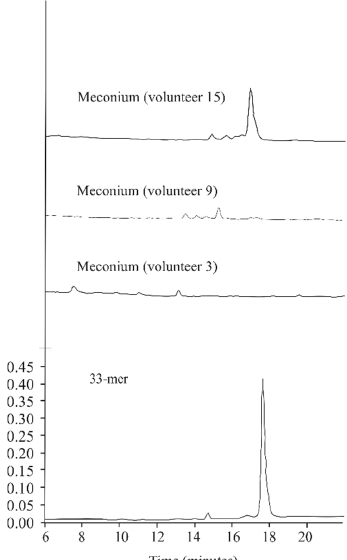
Figure 1. Gluten metabolism in children. ( a ) Bioassay results indicating glutenase activity. Data represent the fecal glutenase activity (FGA) in terms of the number of units of trypsin / g feces of the 21 meconium volunteers. ( b , c ) Gliadinase activity. Gliadin zymogram of meconium results from whole-protein fecal samples from ( b ) six newborn volunteers (1, 2, 5, 7, 9, and 15) and ( c ) from three volunteers (4, 6, and 34) two months old. M: electrophoretic molecular weight marker. Int. J. Mol. Sci. 2020 , 21 , x FOR PEER REVIEW